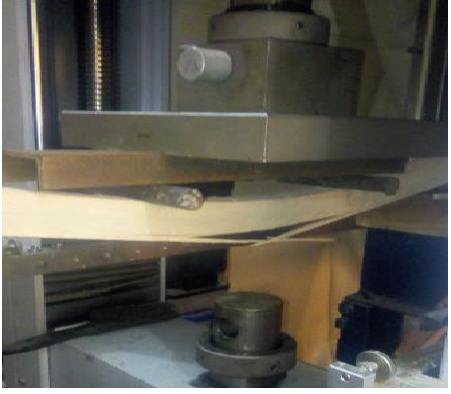
Fig. 2. 4-Point Bending test Setup. Fig. 3. Failure Mode of 4-point Bending